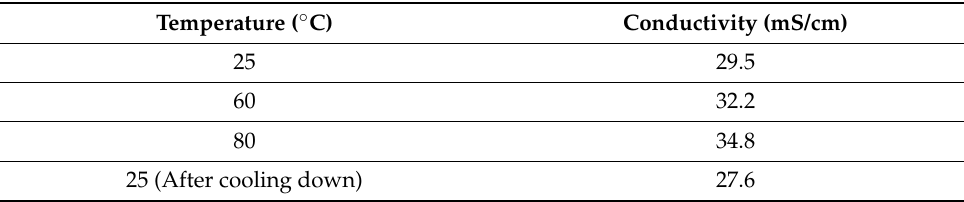
Figure 8. Impedance spectrum of poly(VBCl-hexene)/PVA blend membrane at 25 °C. The through-plane ionic conductivity of the blend membrane, calculated according to eq. 1, is reported in Table 2 as function of the temperature. Table 2. Ionic conductivity of blend membrane in OH − form.